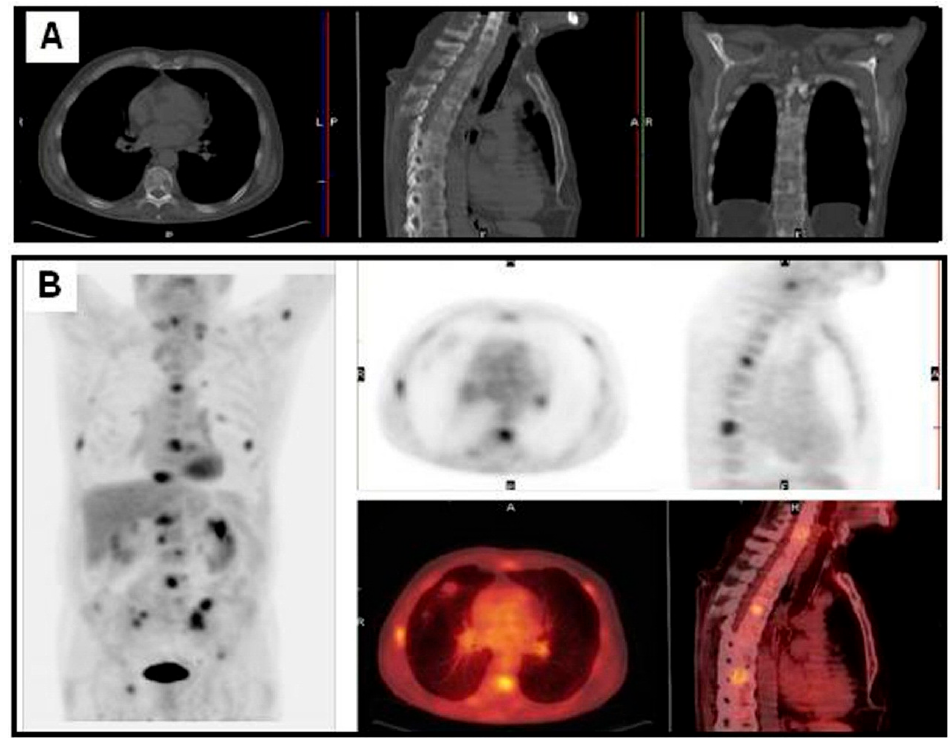
Figure 4. Patient with a NSCLC in the left superior lobe treated three years before with chemo- radiotherapy. A radiological exam showed sclerotic bone lesions ( A ). FDG PET/CT showed multiple bone, left supraclavicular lymph nodes and lung metastases ( B